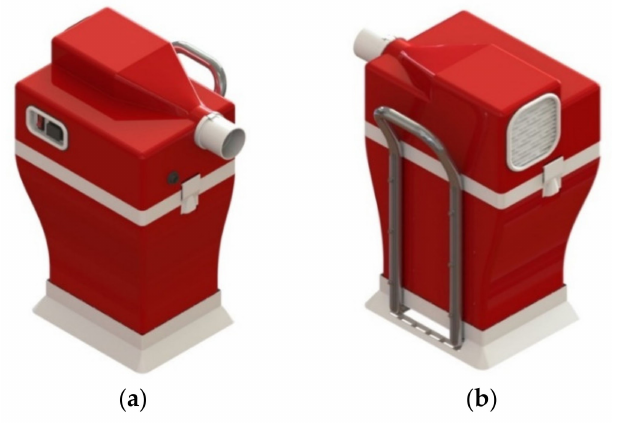
Figure 6. Portable collecting device; ( a ) front view; ( b ) back